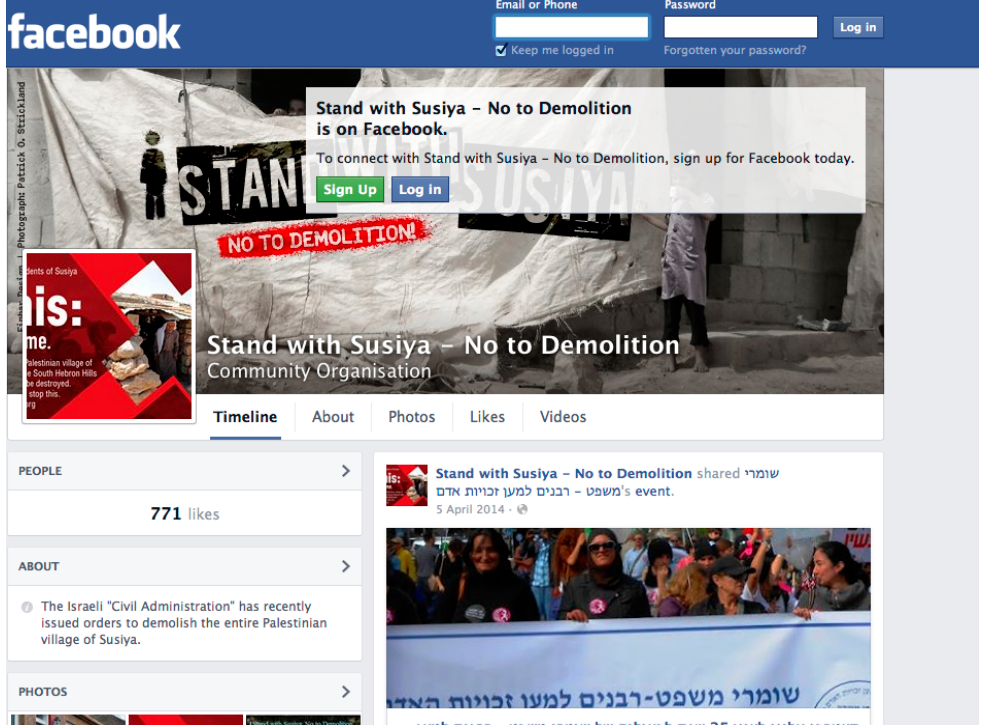
Figure 3. Screen grab of the Stand with Susiya—No to Demolition Facebook page (Accessed on 5 July 2012).